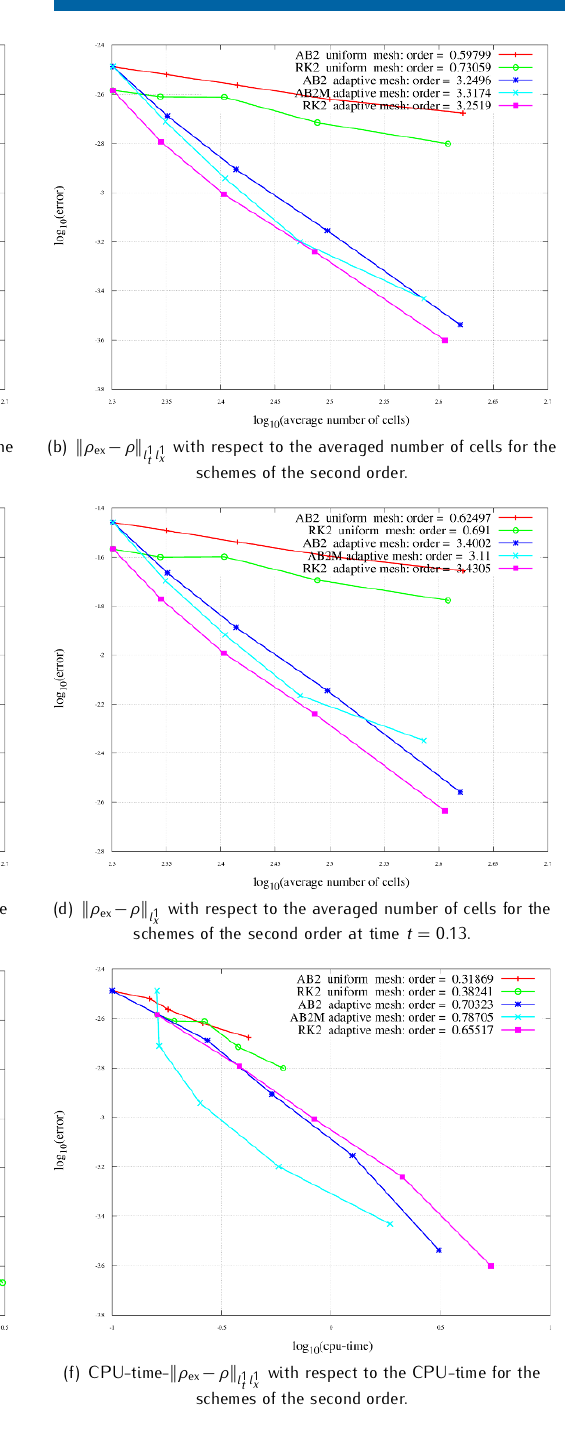
Figure 11. Lax’s shock tube problem: numerical